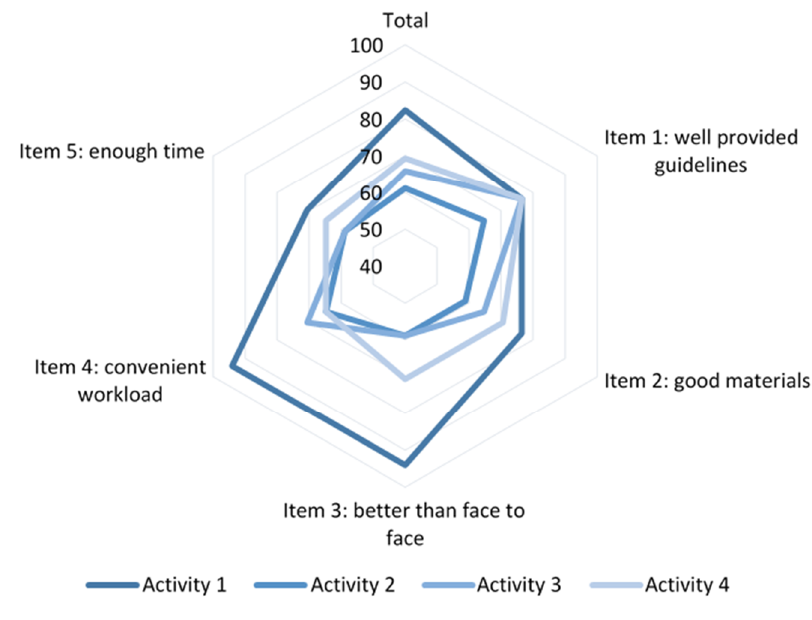
Figure 4. Radial graphic of agreement percentage for each item in all activities.